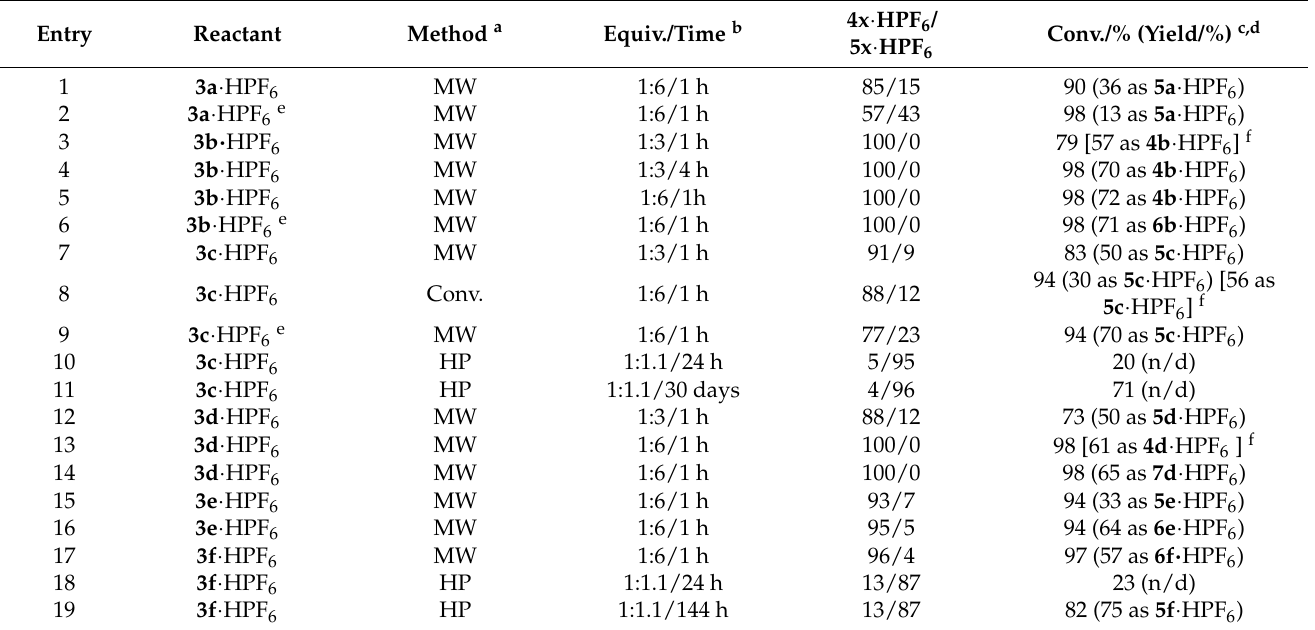
a Reaction conditions are given in the Section 3. b Equiv. relates to the starting molar ratio of the guanidines salts 3(a – f) · HPF 6 and DMAD used. The amount of DMAD corresponds to the n used in Scheme 1. c Conversion · s determined from the 1 H NMR spectra of the crude reaction mixture. d Isolated, nonoptimized yield, n/d = not determined. e Aged sample of 3a · HPF 6 , 3b · HPF 6 , or 3c · HPF 6 stored over two months in a closed flask and not dried. f NMR yields calculated using p -dimethoxybenzene or N 1 , N 3 -dimethylthiourea as the internal standard are given in square brackets.